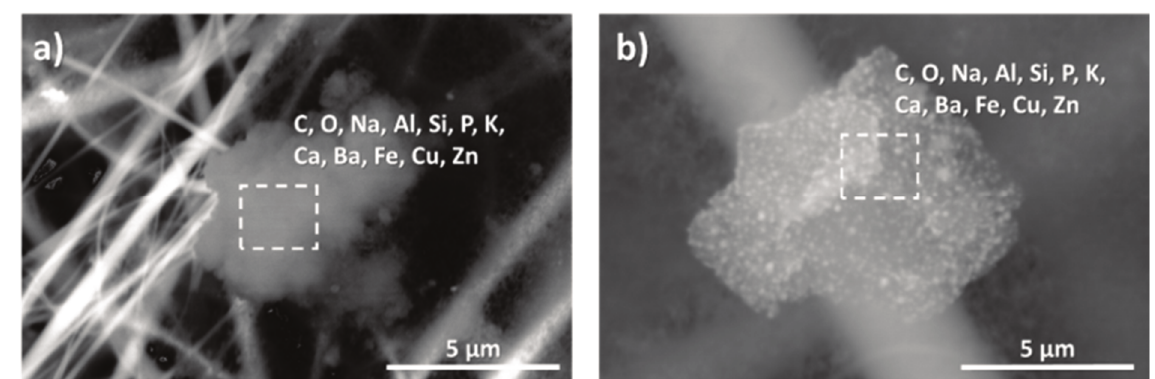
Fig. 5. BSE micrographs of particles with areas for EDS analysis marked a) sample no. 1046 b) sample no.